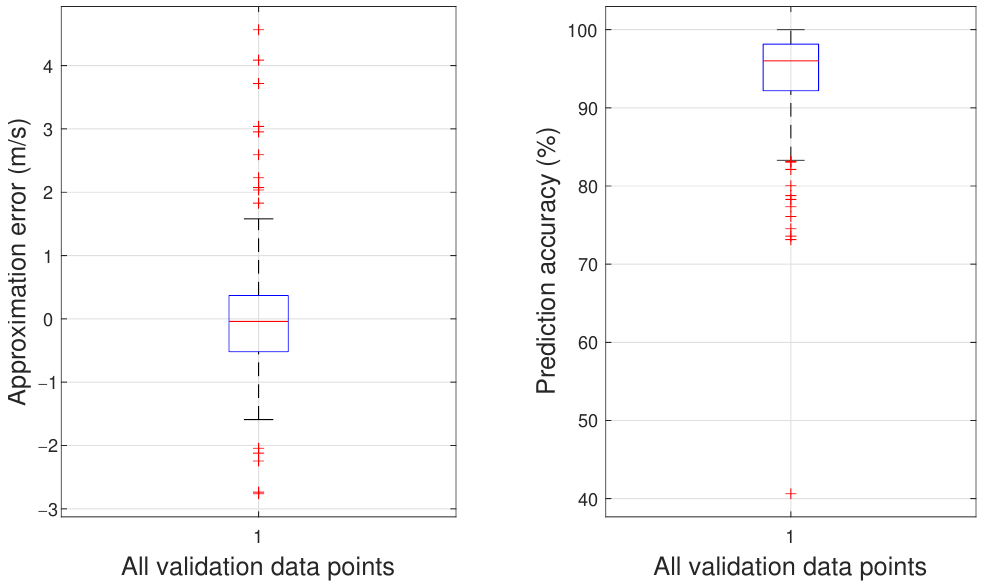
Figure 10. Approximation errors ( left plot) and prediction accuracy ( right plot) of the model with the lowest RMSE over the validation dataset.